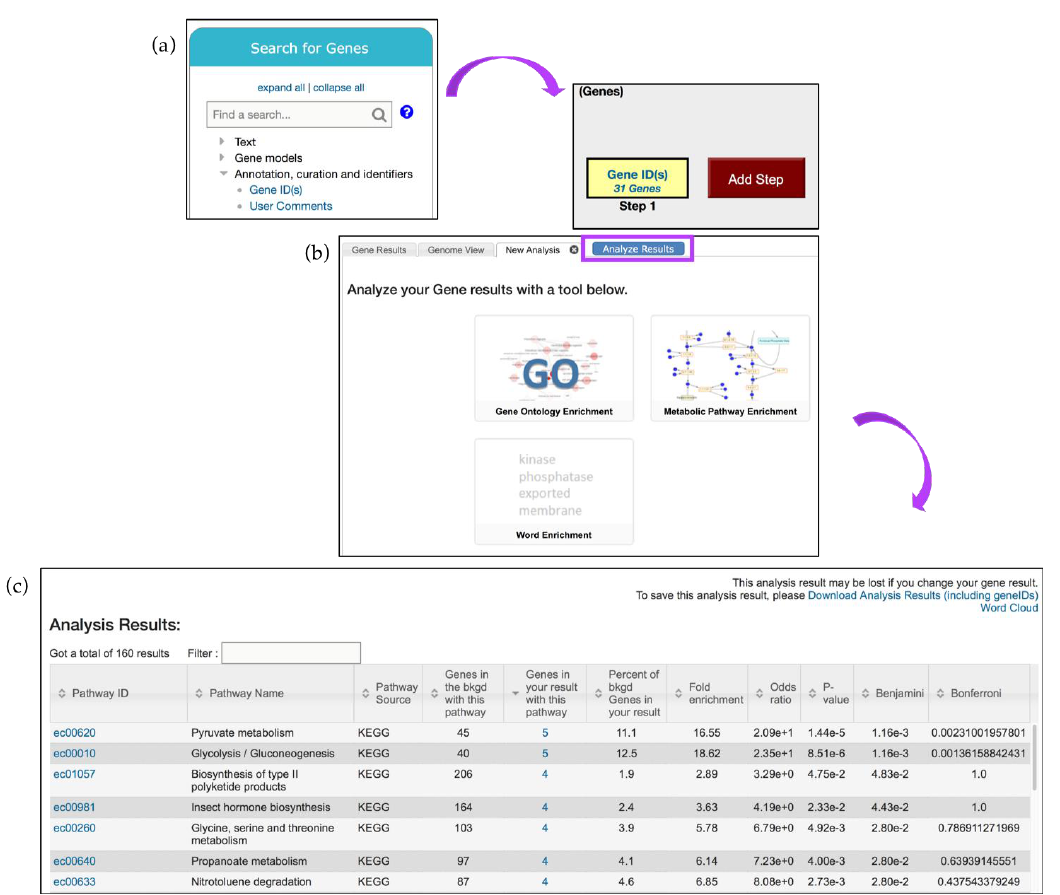
Figure 9. Metabolic pathway enrichment analysis. ( a ) A list of 31 genes is analyzed via the Gene IDs tool (from the Search for Genes panel) and the ( b ) the Metabolic Pathway Enrichment tool from the Analyze Results tab (highlighted in purple) ( c ) Metabolic Pathway Enrichment analysis results page.